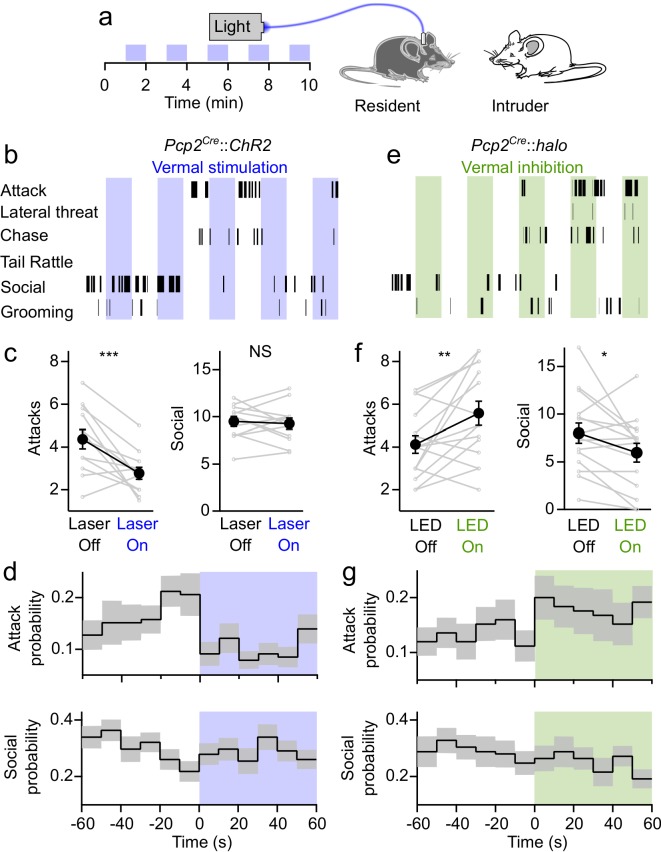
Bidirectional control of aggression by optogenetic modulation of vermal Purkinje cell activity.(a) Schematic for resident-intruder assays with optogenetic stimulation. (b) Representative scoring of social and aggressive behaviors. (c) Average number of attacks and social encounters during ChR2 assays (31 assays from 12 residents). (d) Peristimulus time histogram of the probability of attacks (top) and social investigations (bottom) within 10 s bins during epochs with and without ChR2-mediated excitation of vermal PCs. (e–g), Same as in (b–d), but during Halorhodopsin-mediated inhibition of vermal PCs (34 assays from 15 residents).Figure 3—source data 1.Resident Intruder Halo Vermis data.Figure 3—source data 2.Resident Intruder No Opsin Vermis data.